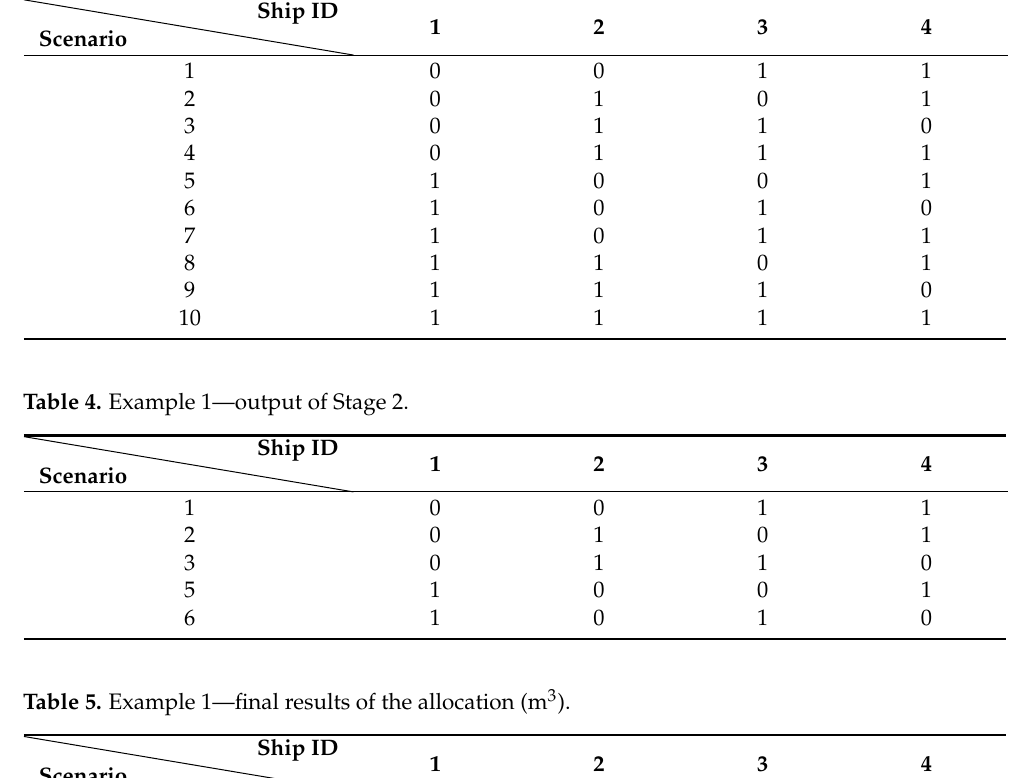
Table 3. Example 1—output of Stage 1.